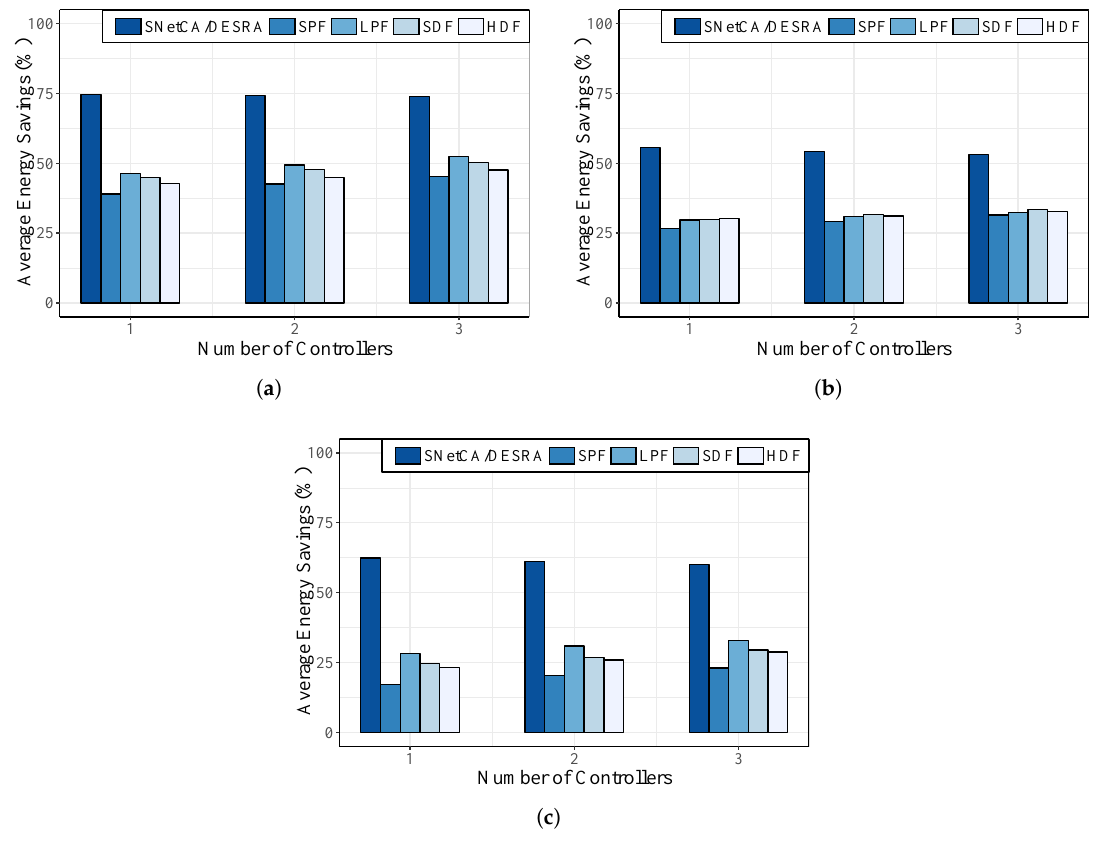
Figure 5. Average energy savings comparison between proposed strategy and SGH solutions for different numbers of controllers in the: ( a ) New York topology; ( b ) Geant topology; and ( c ) Norway